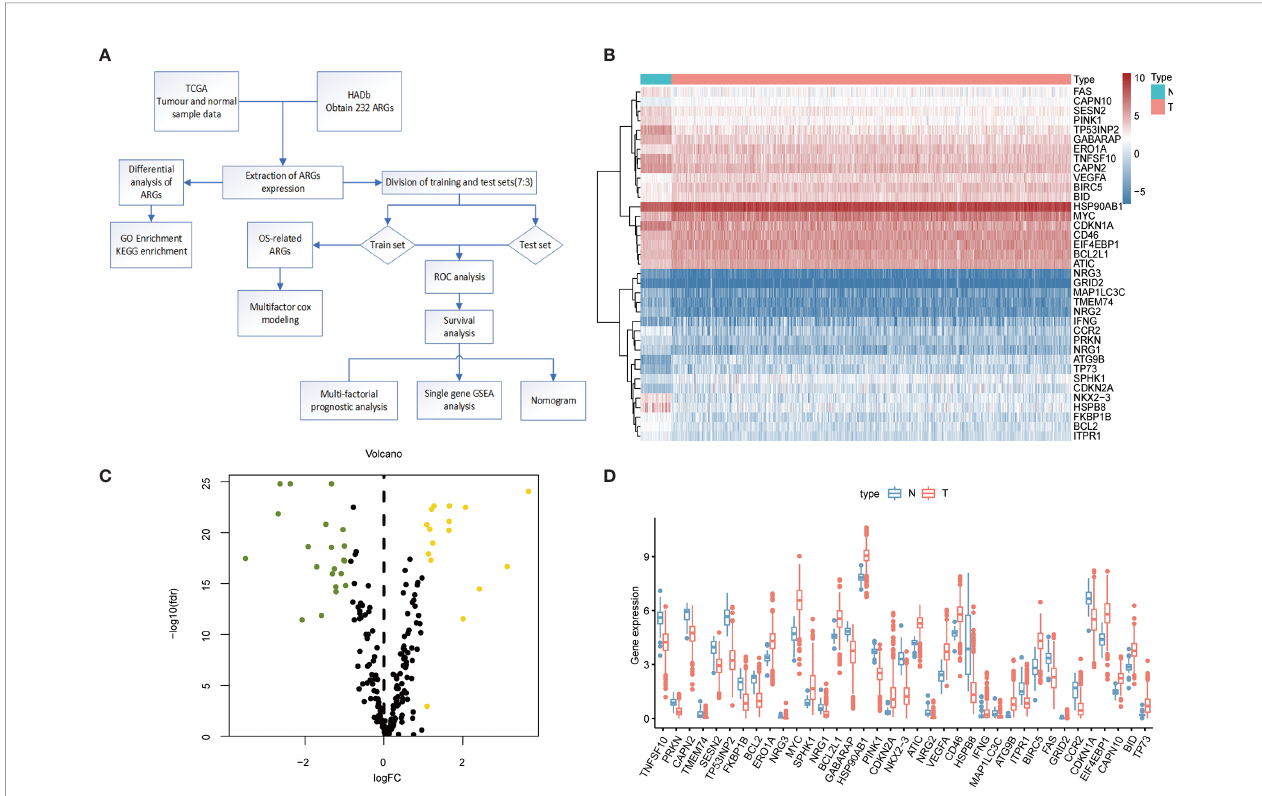
FIGURE 1 | Differential expression of ARGs between colorectal cancer and normal tissues. (A) Research Flowchart. (B) Clustered heat map of expression levels of 37 autophagy differential genes. Green is normal tissue; Orange is tumor tissue. Red indicates high expression, blue indicates low expression. (C) Volcano diagram of ARGs expression, with green indicating low expression and yellow indicating high expression. (D) Expression of 37 ARGs in colorectal cancer tumor tissues and paired non-tumor samples. Red represents tumor samples and blue represents non-tumor samples. ARGs, Autophagy-Related Genes; FDR, false discovery rate; FC, Fold Change; TCGA, The Cancer Genome